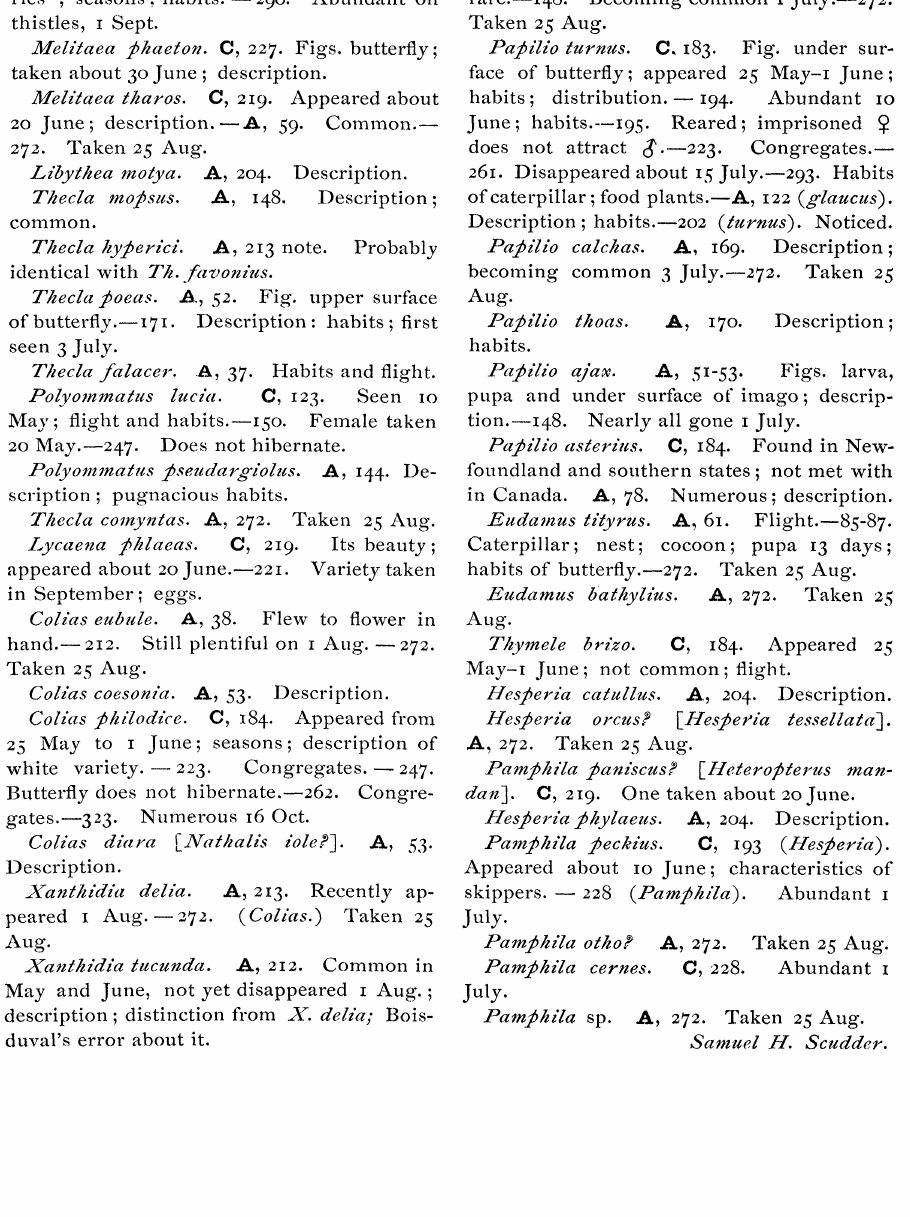
Fig. under sur- face of butterfly; appeared 25 May-i June habits distribution.-- 194.